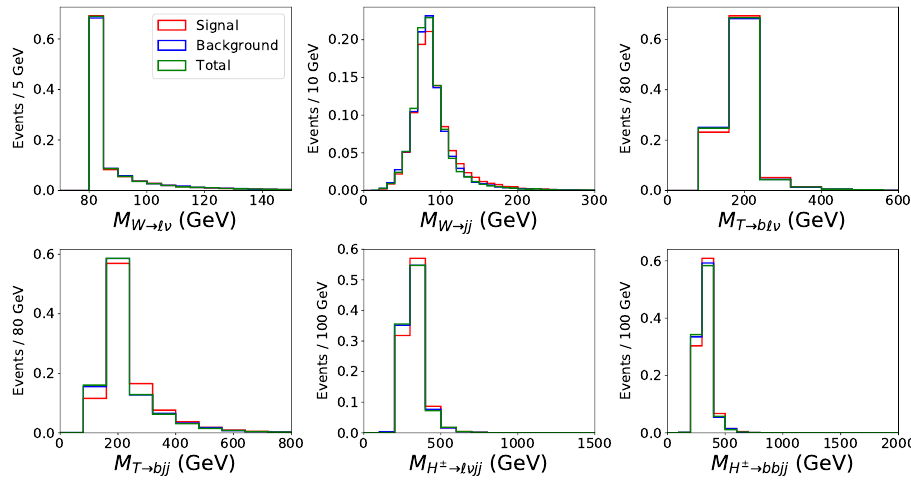
Figure 5. Invariant mass distributions for reconstructed particles in the m mod +